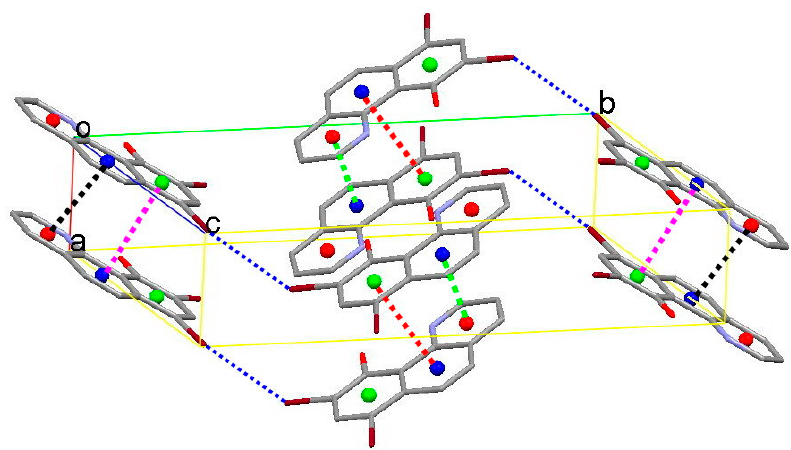
Figure 2. Part of the crystal structure in the unit cell of 1 , showing the formation of the dimmer built from π ⋅⋅⋅ π interactions. C g1 (red circles), C g2 (green circles), and C g3 (blue circles) are the centroids of the C8–C12/N, C1–C5/C13, and C5–C8/C12/C13 rings, respectively. The black, pink, green, and red dashed lines denote different intermolecular π ⋅⋅⋅ π interactions. The blue dashed lines denote intermolecular Br(1) ⋅⋅⋅ Br(2) contacts. All hydrogen atoms are omitted for clarity.